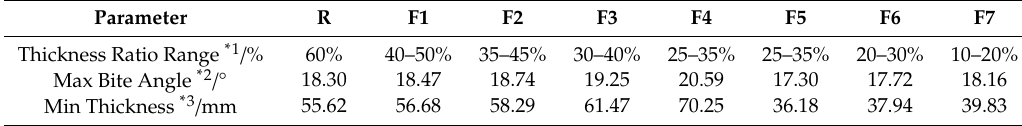
Table 3. Main process requirements constraints of Q235 steel.